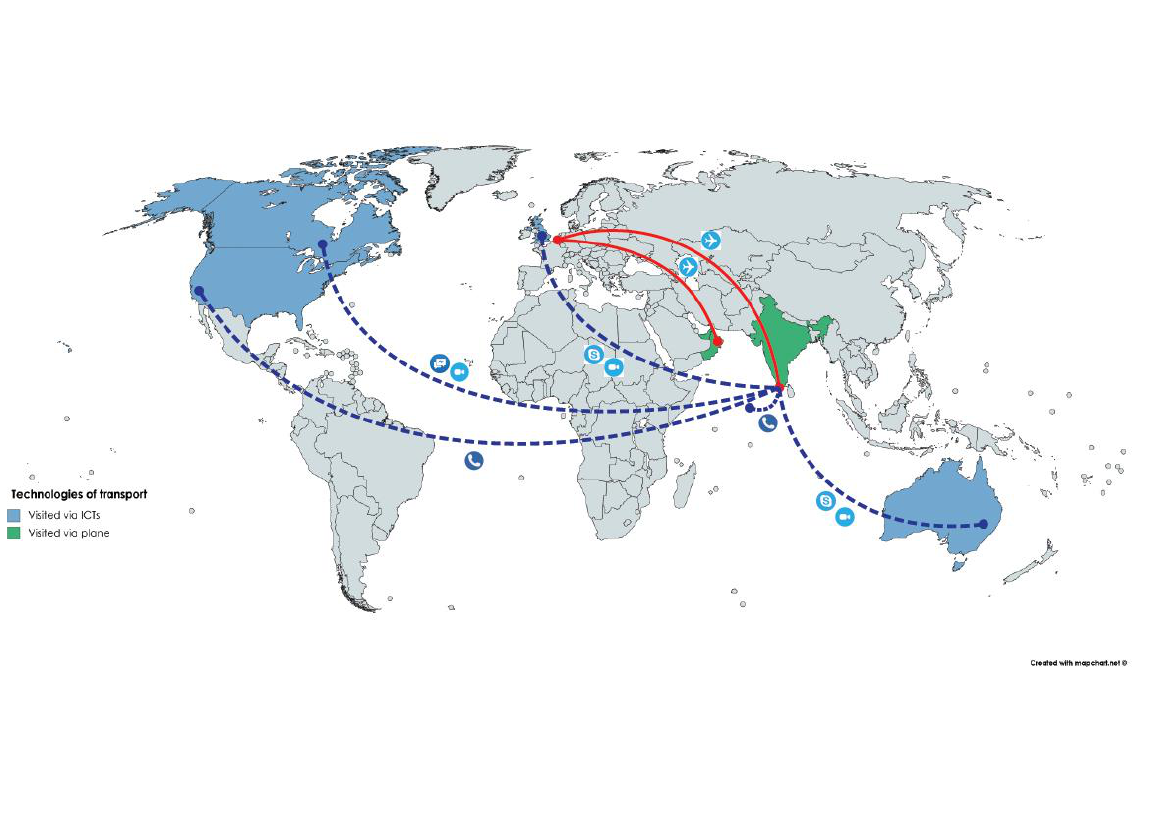
Figure 1. This is not a field site. Graphic by Ahlin. Note: The solid lines could represent the ethnographer ’ s physical travel from the Netherlands to Kerala and Oman, and the dotted lines could represent her travel via ICTs to reach people in various geographical locations around the world. But if the field is imagined as a collection of field events, where is the field in this